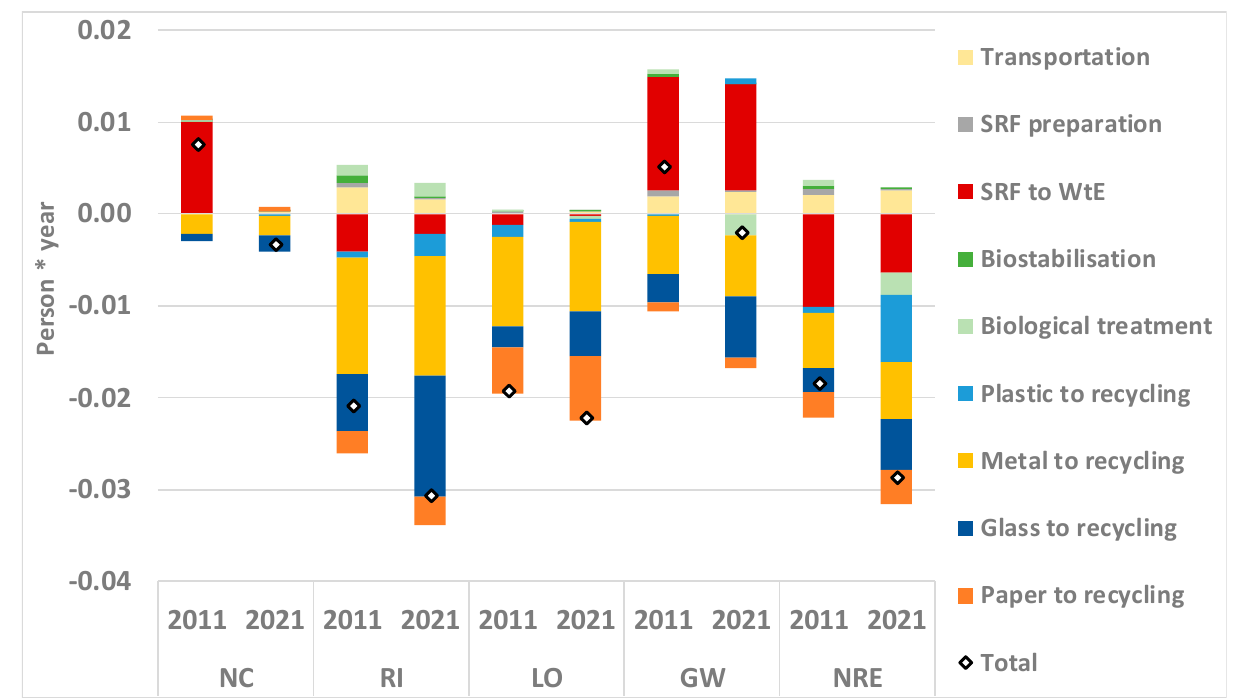
Figure 5. Life-cycle impact assessment for Procida’s MSW management in 2011 and 2021, with the contributions of each specific stage. Results refer to the chosen functional unit (“the treatment of 1 tonne of MSW”) and are normalised in “person*year” (the average impact in a specific category caused by a person during one year in Europe). NC = non-carcinogens; RI = respiratory inorganics; LO = land occupation; GW = global warming; NRE = non-renewable